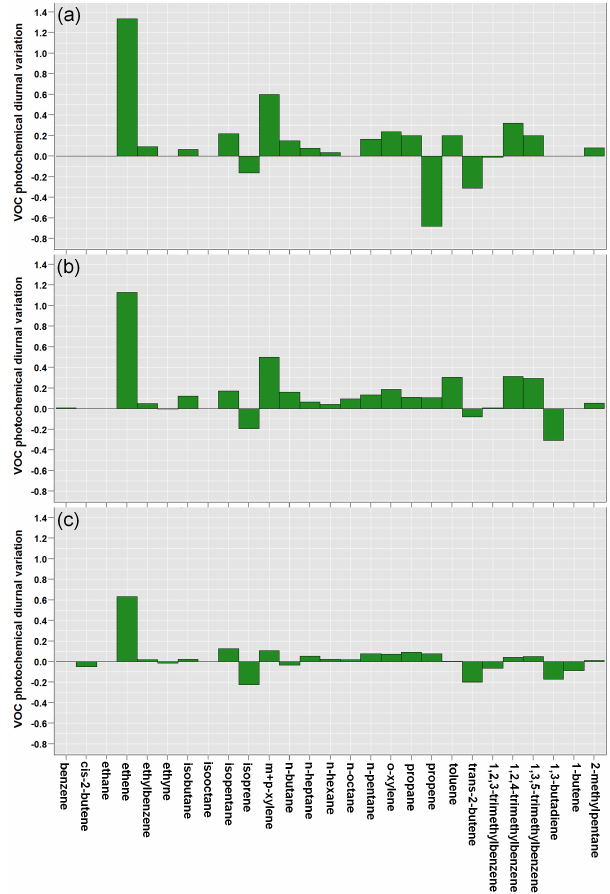
Figure 7. Individual VOC diurnal photochemical reactivity as de- fined by the difference between night (average of 01:00–05:00) and afternoon (13:00–17:00) POCP-weighted VOC / ethane ratios for (a) June 2010, (b) July 2011 and (c) July 2012 at Harwell. A lower ratio in the afternoon results in a positive value (i.e. photochemi- cal depletion), while a higher afternoon ratio results in a negative value. These months correspond to the periods of annual maximum regional O 3 increment at Harwell (see Fig.